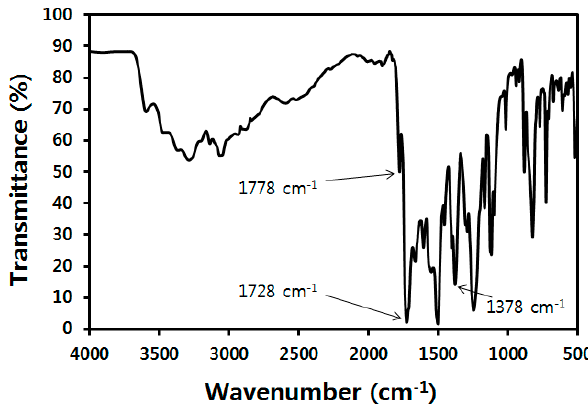
Figure 1. FT-IR spectrum of PMDA-ODA oligoimide synthesized in water.